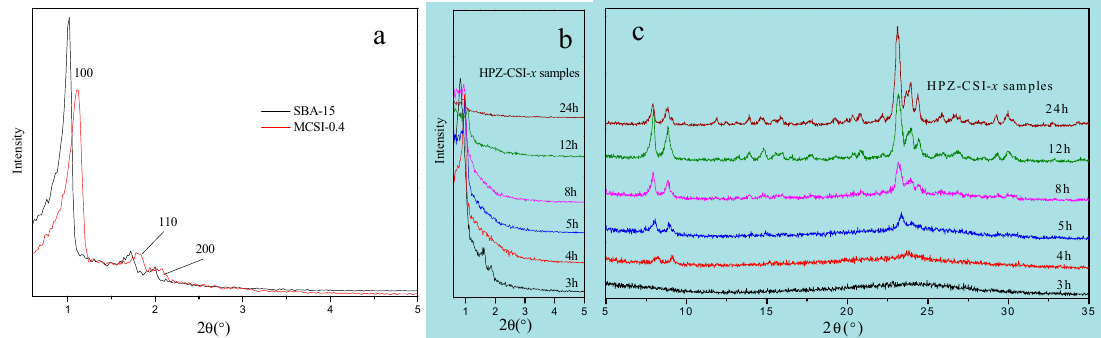
Figure 3. Small-angle (a,b) and wide-angle (c) powder XRD patterns of MCSI-0.4, SBA-15, and HPZ-CSI-x samples.